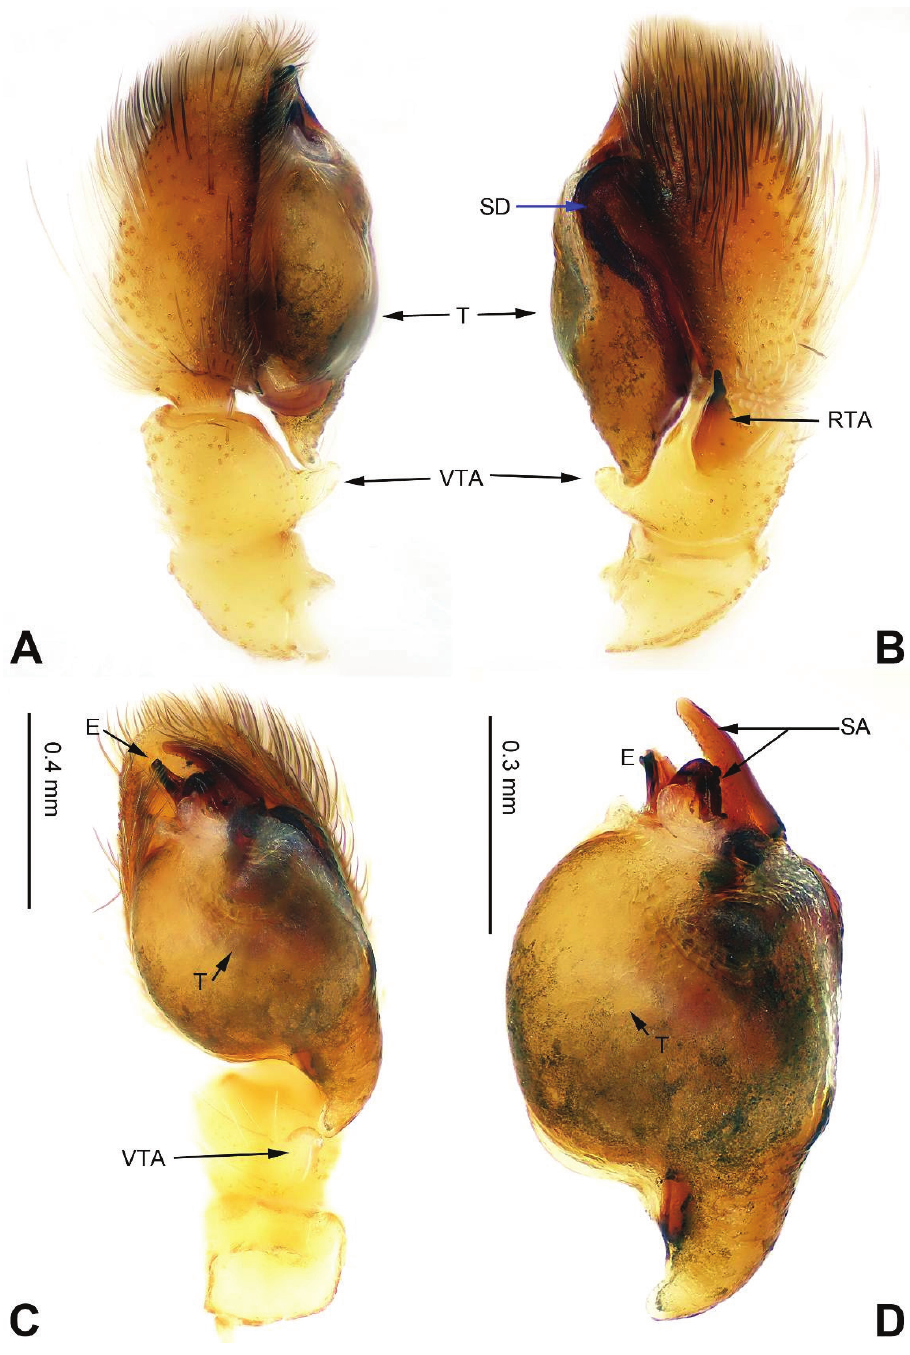
Figure 40. Palp of Stenaelurillus fuscus sp. n., male holotype. A prolateral B retrolateral C ventral D bulb, ventral. Scale bar equal for A–C